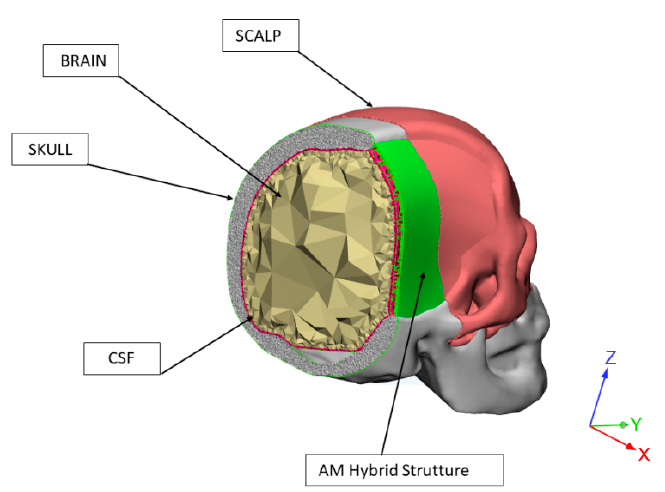
Figure 6. A simplified image reporting some components of the finite element analysis (FEA) model.